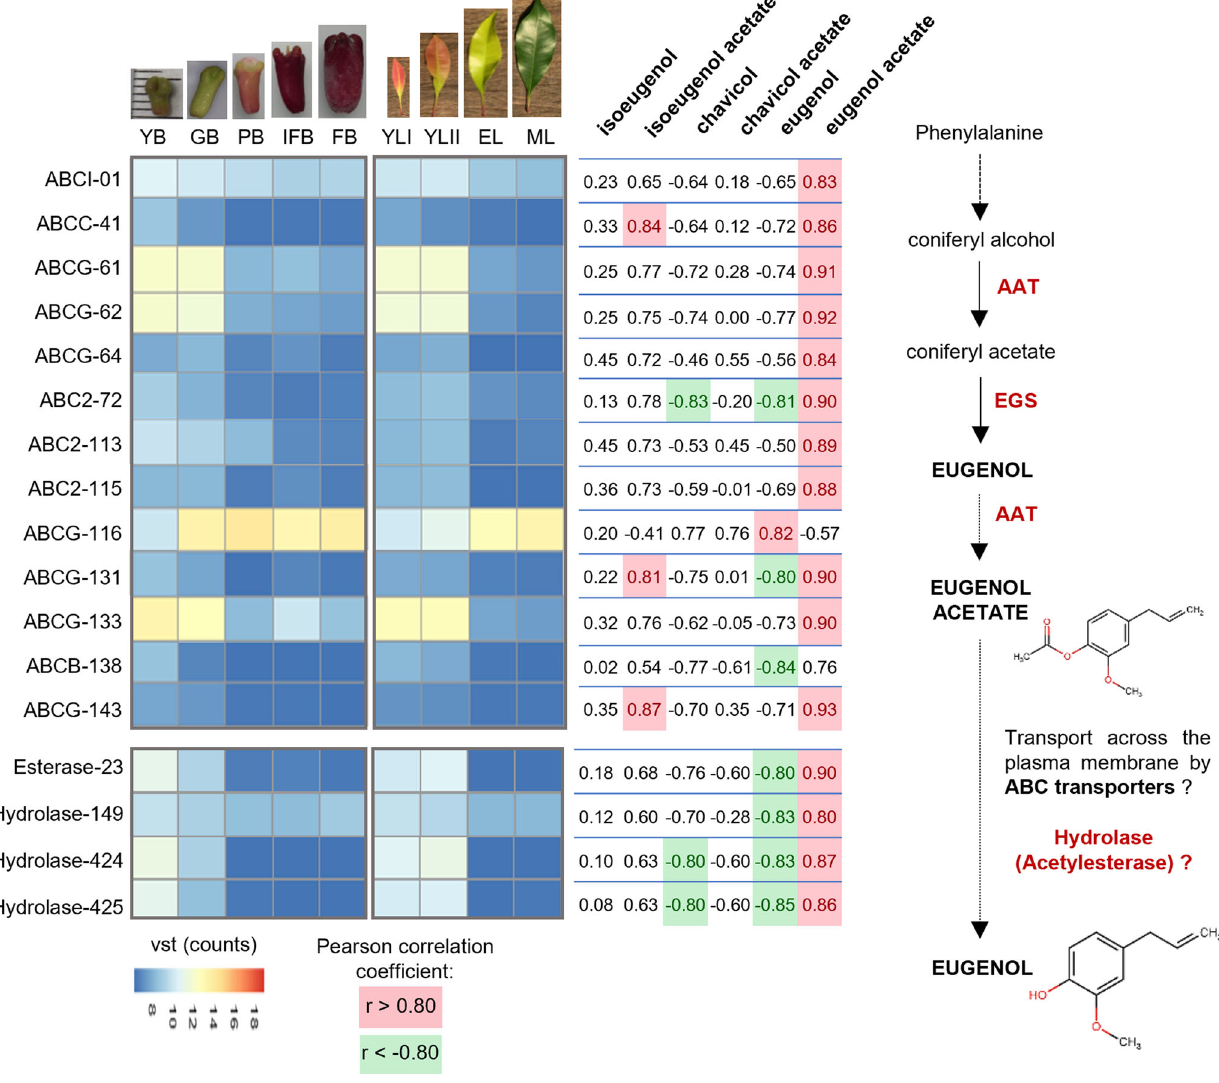
Fig. 7 Biosynthesis of eugenol in Syzygium aromaticum leaves and buds. Proposed hypothetical scenario in which eugenol acetate is converted to eugenol, on the basis of transcriptomic and metabolomic data analysis. Heatmaps indicate the expression pro fi les of genes correlated with the concentrations of the phenylpropenes eugenol, eugenol acetate, chavicol, and isoeugenol acetate (Pearson correlation coef fi cient r > 0.8 to r < − 0.8, n = 3). AAT alcohol acyltransferase, EGS eugenol synthase, ABC ATP-binding cassette transporter. Young buds (YB), green buds (GB), pink buds (PB), buds in the initial fruiting stage (IFB), buds in fruiting stage (FB), young leaves (YLI), expanded young leaves (YLII), expanded pale green leaves (EL), and mature leaves (ML). VST variance stabilizing